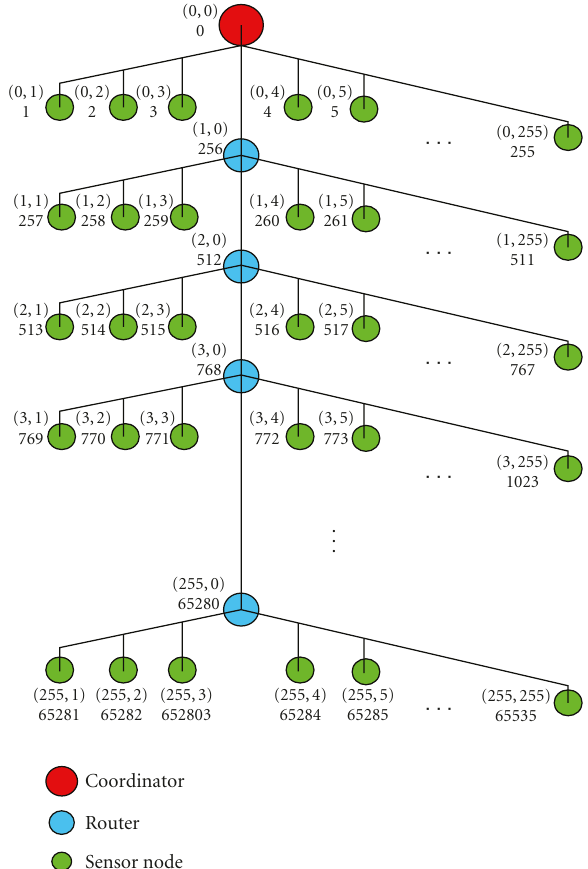
Figure 6: Best possible addressing configuration of our two-dimen- sional